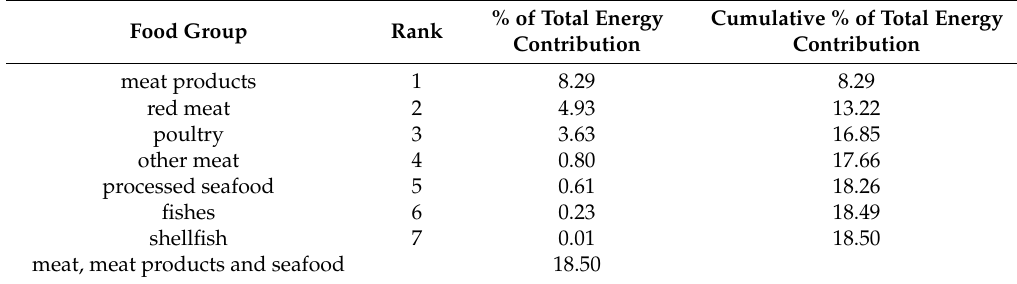
Table 2. Food group sources of energy (kcal) contribution from meat, meat products and seafood in the average Polish diet.